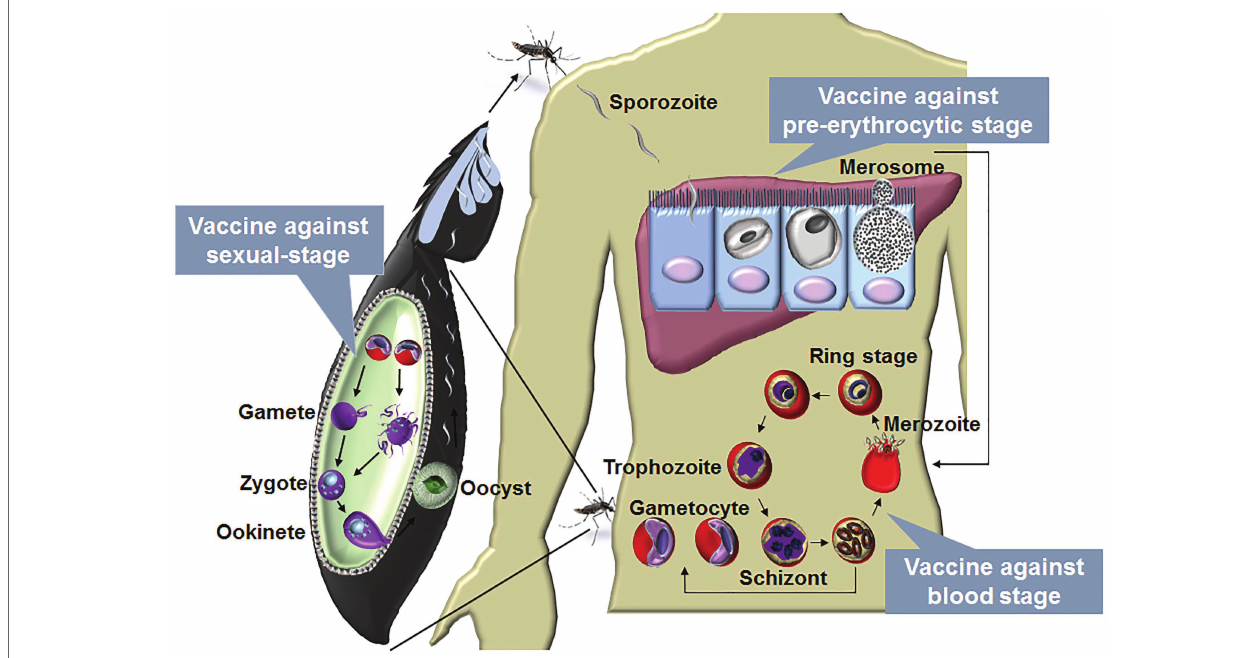
FIGURE 1 | The life cycle of malaria parasite and vaccines designed against each stage. The life cycle of Plasmodium includes liver stage and blood stage in human and sexual-stage in the mosquito vector. A Plasmodium infection begins when an infected female Anopheles mosquito takes a blood meal and injects a small number of sporozoites into a human host. The sporozoites enter blood vessels and invade target hepatocytes, with a single sporozoite giving rise to tens of thousands of merozoites. Next, merozoites are budded from an infected hepatocyte by the merosomes and rupture to release thousands of merozoites into the bloodstream. In the bloodstream, the merozoites invade RBCs, initiating blood-stage development. A merozoite, which subsequently develop into ring, trophozoite, and schizont stage parasites, can multiply up to 20-fold every 1 to 3 days in cycles of invasion, replication, and RBC rupture. New daughter merozoites are